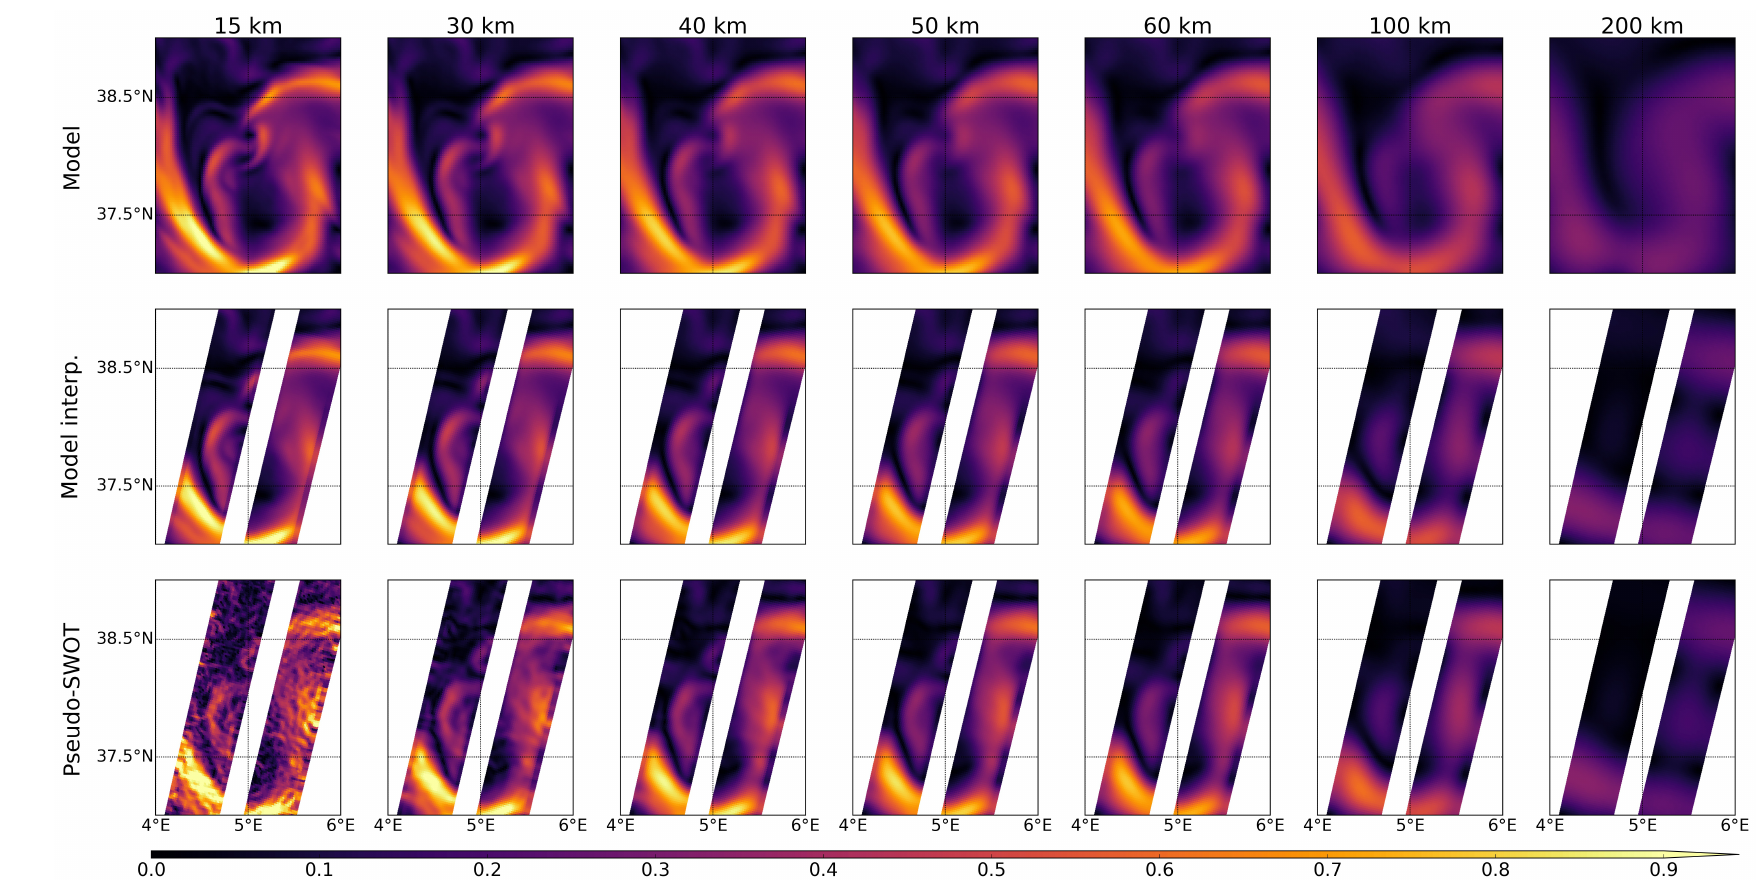
Figure 9. Absolute geostrophic velocity (m/s) on 23 January 2009 corresponding to pass 15 of cycle